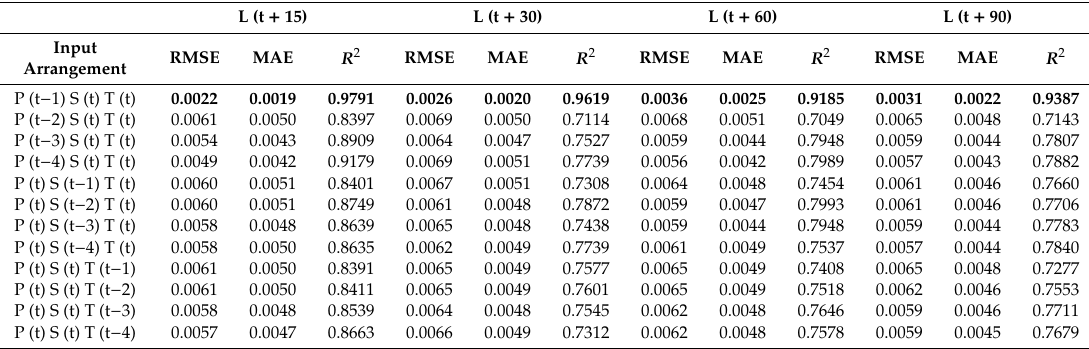
Table 2. Performance evaluation criteria for 15, 30 60, and 90 days lead-time groundwater level variations using the KNN-RF